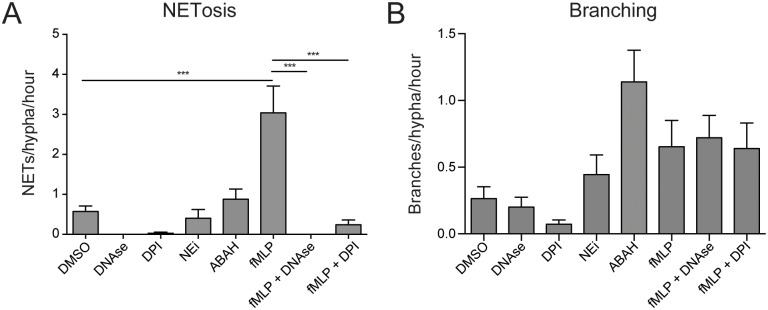
Apical branching is induced at sites of neutrophil interaction independently of ROS production and NETosis.(A) Treatment with known regulators of NETosis allowed manipulation of NET formation by neutrophils in this system. (B) Inhibition of NETosis by DPI or DNAse treatment had no influence on the increased branching levels observed in fMLP-treated groups, suggesting that this effect was independent of NETosis. N ≥ 25 hyphae scored from 3 experiments. Errors bars: mean ± SEM. Statistics: One-way ANOVA with Tukey’s post test. Adjusted p values: *p≤0.05, **p≤0.01, ***p≤0.001, ****p≤0.0001.